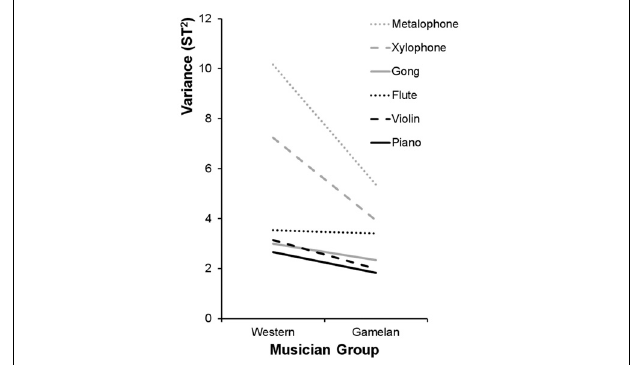
FIGURE 4 | Sample variance of the pitch matching distributions (cf. Figure 3) for each instrument type and each musician group. ST =